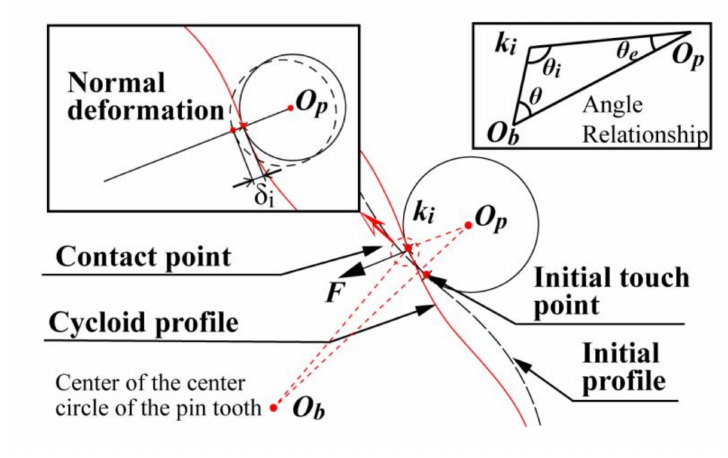
Figure 5. Tooth contact force considering clearance.